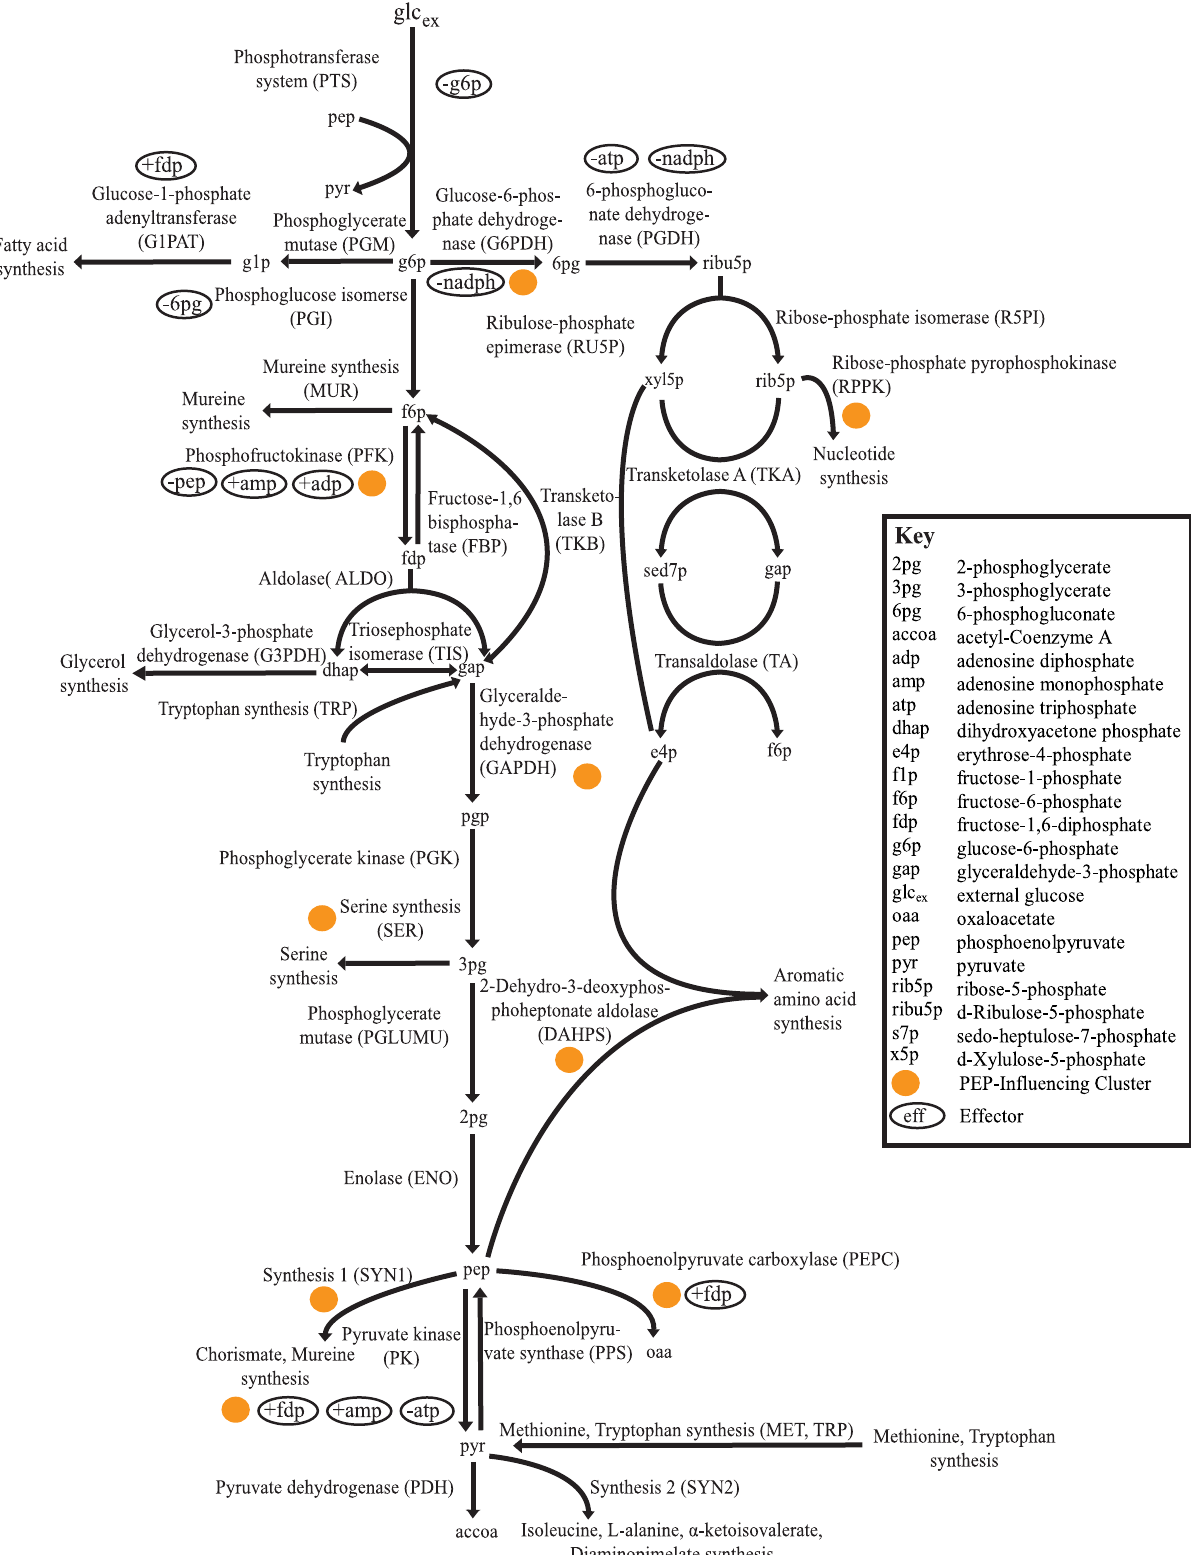
Figure 1. Model system of central carbon metabolism. This kinetic model includes glycolysis, gluconeogenesis, and the pentose phosphate pathway. The model assumes that glucose is the feed substrate and is catabolized into various smaller compounds. Each node is a single metabolite (written in lower case) and these nodes are connected by reactions (written in capital letters). Reactions with multiple metabolites leading into the